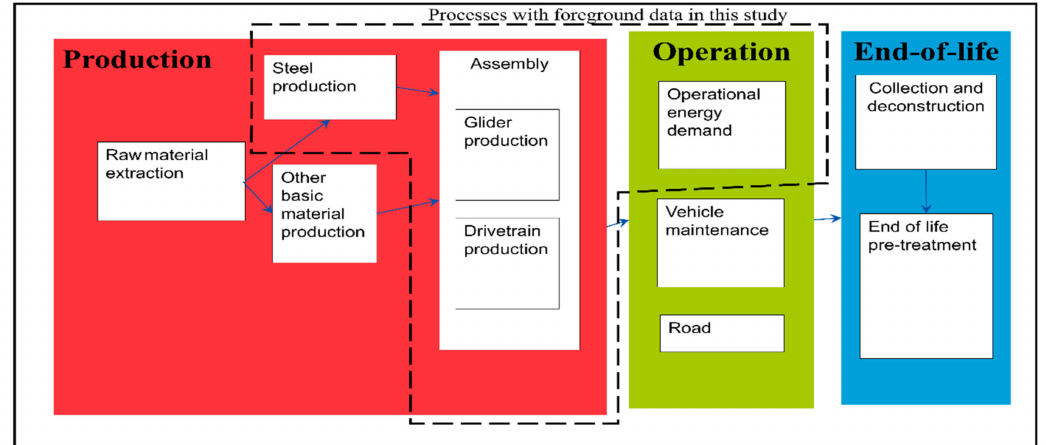
Figure 1. System boundary for all vehicle alternatives considered in this